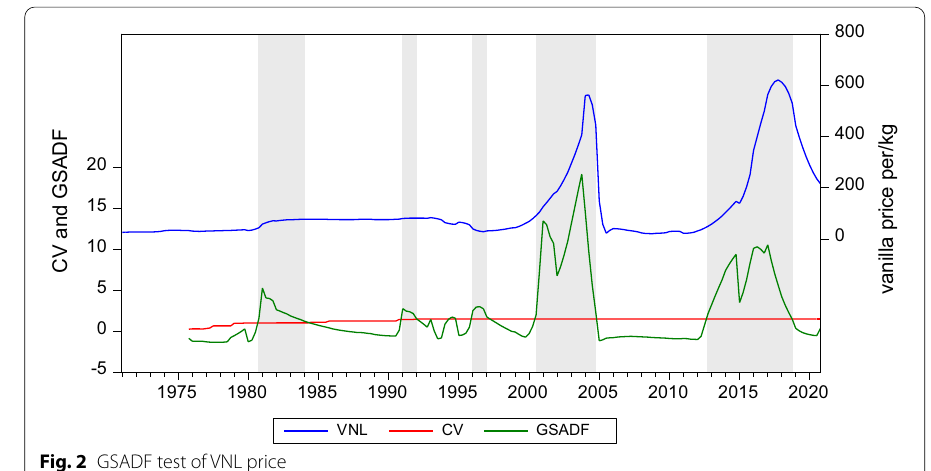
Fig. 2 GSADF test of VNL